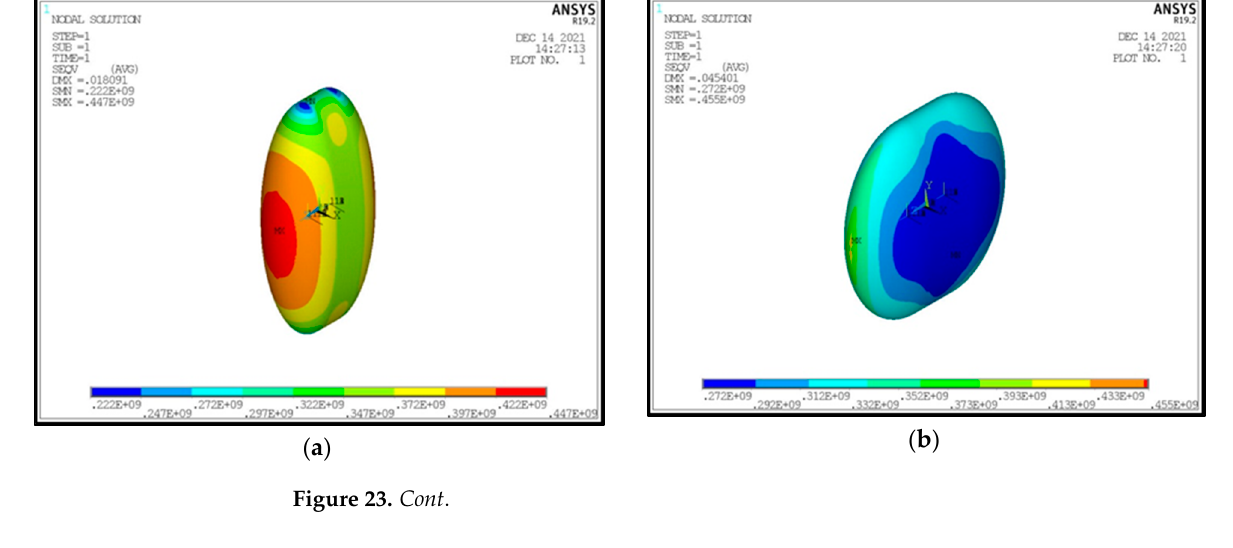
( d ) ( e ) Figure 23. Characteristic tank case with transition of the maximum Von Mises stress between dif- ferent tank regions ( λ = 0.25, φ = 0.333, ψ = 0.333 ( a ), 0.666 ( b ), 1 ( c ), 1.5 ( d ), 3 ( e )). 4. Discussion and Results The tank fullness level, at least for the issues considered in the present study, does not seem to substantially affect the two parts of the tank into which the liquid hydrogen level separates very differently. A small difference in the temperatures of the aluminum shell, on the order of 2°C (2 K), is observed due to its direct contact with liquid and gas-